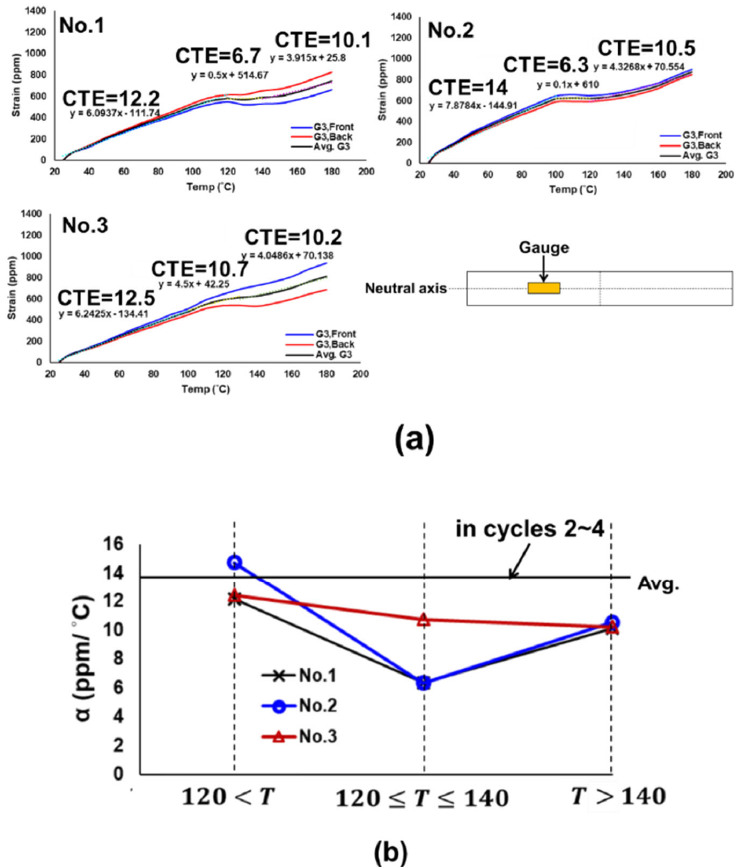
Figure 10. ( a ) Strain data from the front and back gauges for three sockets during the fi rst thermal loading cycle, and ( b ) temperature-dependent CTEs of three sockets obtained from gauges for the fi rst thermal cycle and their comparison with those for the second to fourth cycles. (b) CTE of Bare